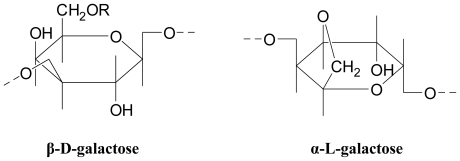
Agar constituents [31] (R=H or CH3).